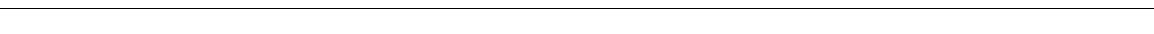
Fig. 2 ACE-Scan generates rich ligand-binding landscapes for the ATP DNA DA family. a Left, secondary structure of the ATP DNA aptamer, with functional regions labeled, shared binding pocket and ligand highlighted in dark (site I) and light (site II) green, and 5 ʹ extension in gray. Right, 3D view of the ATP DNA aptamer consensus sequence bound to two ATP molecules (PDB 1AW4 26 ). b Hybridization signal heat map of ATP DNA DAs for all 7- to 32-mer ACEs, obtained after 16 h of hybridization. In this 5 ʹ heat map representation, each tile represents an experimental surface-based DA biosensor in the form 5 ʹ N:L , representing an ACE of length L (columns) that hybridizes starting at 5 ʹ base N within the aptamer sequence (rows). Tiles are positioned at the 5 ʹ location of ACE hybridization within the aptamer sequence, with tiles lying on southwest by northeast diagonals representing DAs with common 3 ʹ duplex start sites and increasing ACE length (in the format 3 ʹ N:L ). The inset shows the 5 ʹ 1A:11 (or equivalently, 3 ʹ 11G:11 ) DA. Missing white tiles represent DAs that did not pass quality control, and which were subsequently removed from the data set (Methods section). c , d Enantio heat maps, i.e., combined 5 ʹ and 3 ʹ heat map representation, of the response of ATP DNA DAs to incubation with ( c ) buffer only or ( d ) 10 mM ATP. e , f ACE-Scan of single mismatched 12- mer ACEs under ( e ) buffer-only or ( f ) 10 mM ATP conditions. Each tile represents a DA with an ACE of length L that forms a duplex starting at 5 ʹ base N (rows) and that is mismatched at base MM (columns) within the aptamer sequence, in the form 5 ʹ NL:MM . The leftmost column represents perfect match 11- mer ACEs, which are structurally similar to 5 ʹ -terminally mismatched 12-mer ACEs (solid lines in f ). The dotted line highlights the relatively high ligand sensitivity of 5 ʹ 6G-8G:12:14T-17G DAs (black boxes in e , f